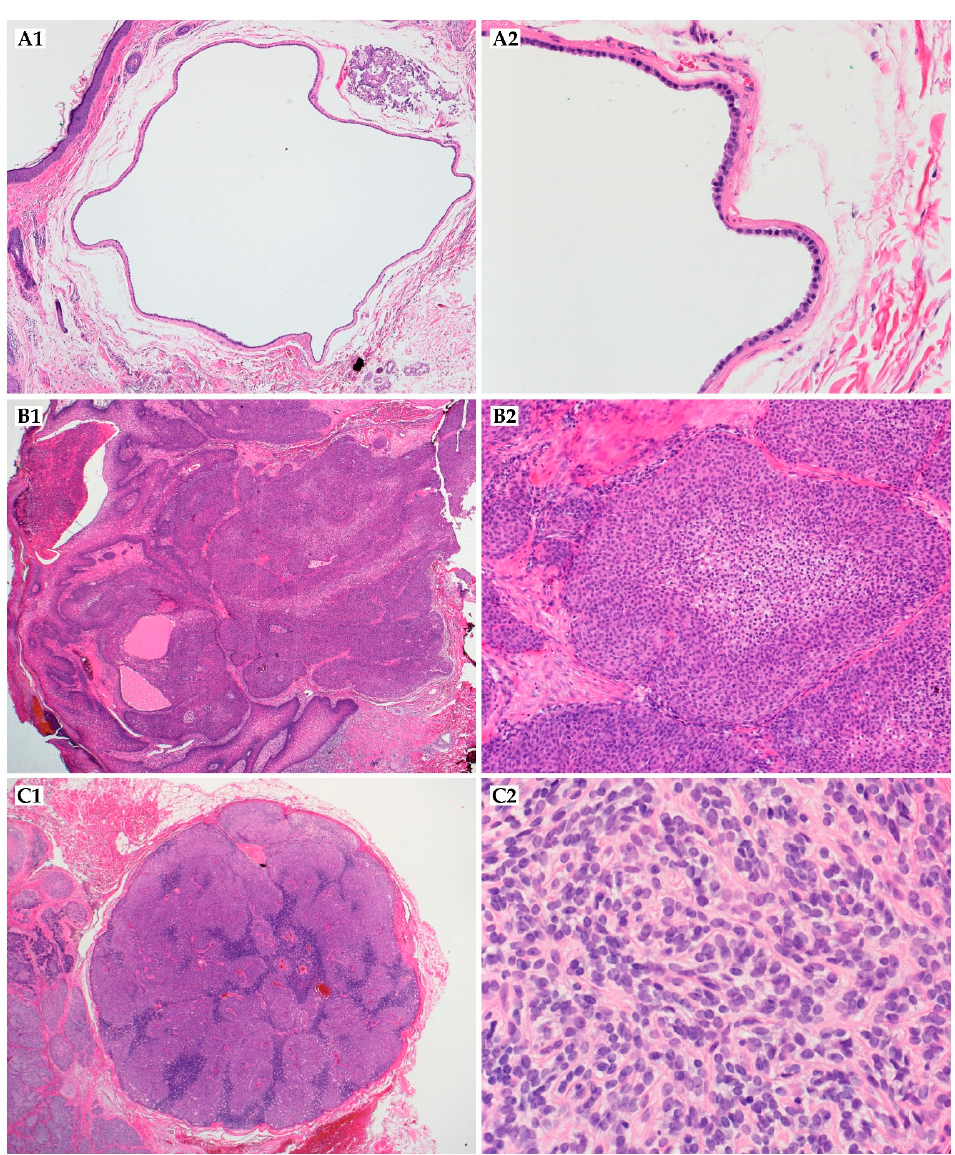
Figure 7. Benign tumors with apocrine or eccrine differentiation I . ( A1 ) (20×, HE) and ( A2 ) (200×, HE): Hidrocystoma: tumor composed of cystic spaces lined with cuboidal epithelium. ( B1 ) (40×, HE) and ( B2 ) (100×, HE): Poroma, a well-circumscribed lesion with poroid and cuticular cells. ( C1 ) (40×, HE) and ( C2 ) (400×, HE): Spiradenoma, well-circumscribed nodules, which consist of basaloid cells with the visible basement membrane material.